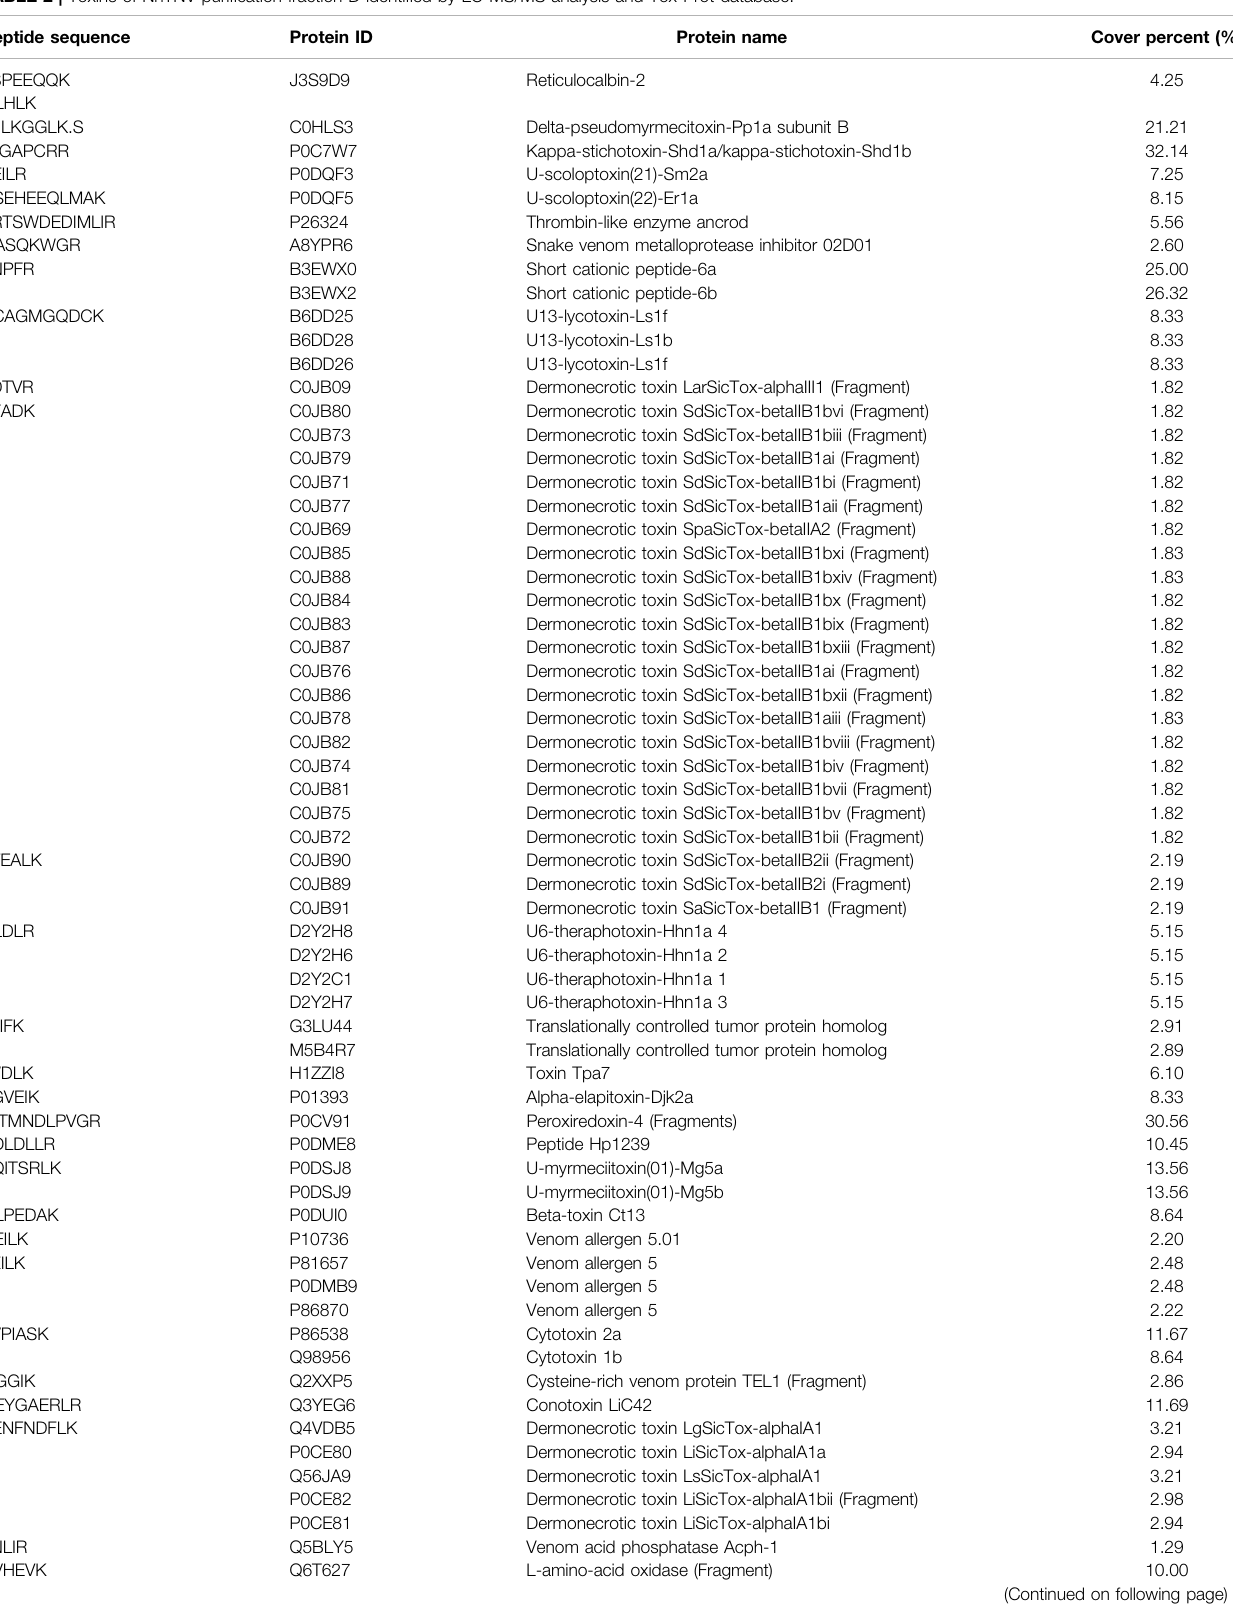
TABLE 2 | Toxins of NnTNV puri fi cation fraction D identi fi ed by LC-MS/MS analysis and Tox-Prot database. Peptide